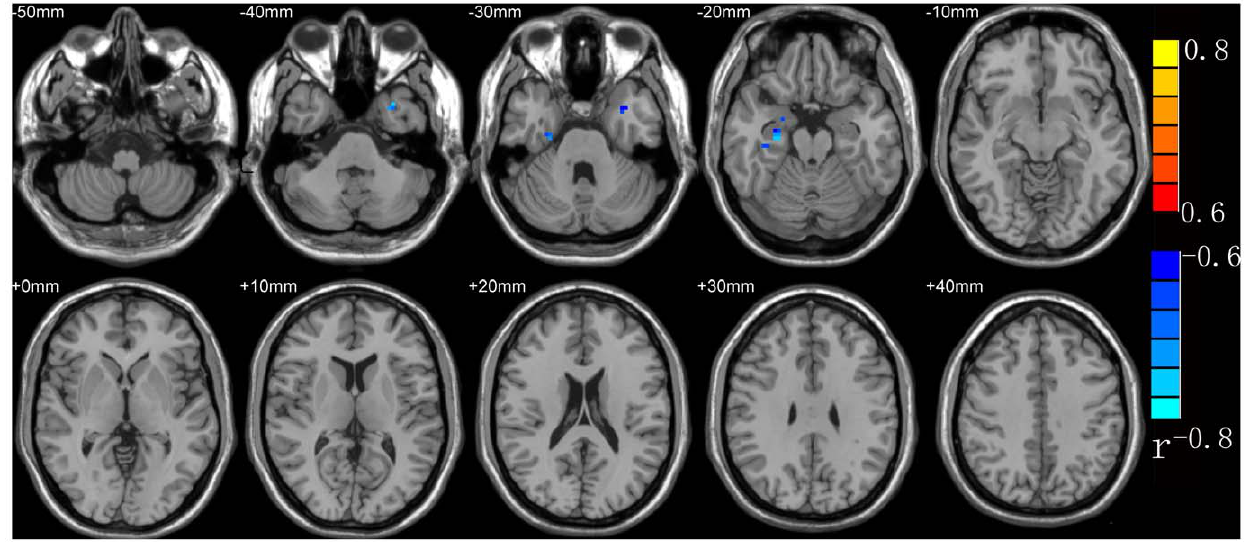
Figure 1. Brain regions where functional connectivity with the PCC was correlated with CAPS at the time when patients were diagnosed with PTSD. Note: The right part of the figure represents the patient’s left side. PTSD=post-traumatic stress